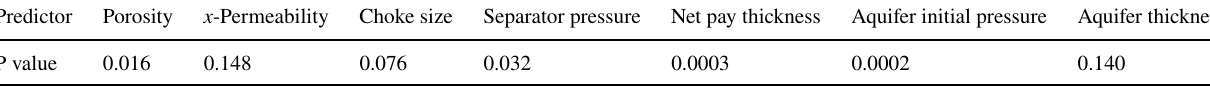
Table 10 The values of P value calculated for the seven parameters with the greatest effect on the target function Predictor